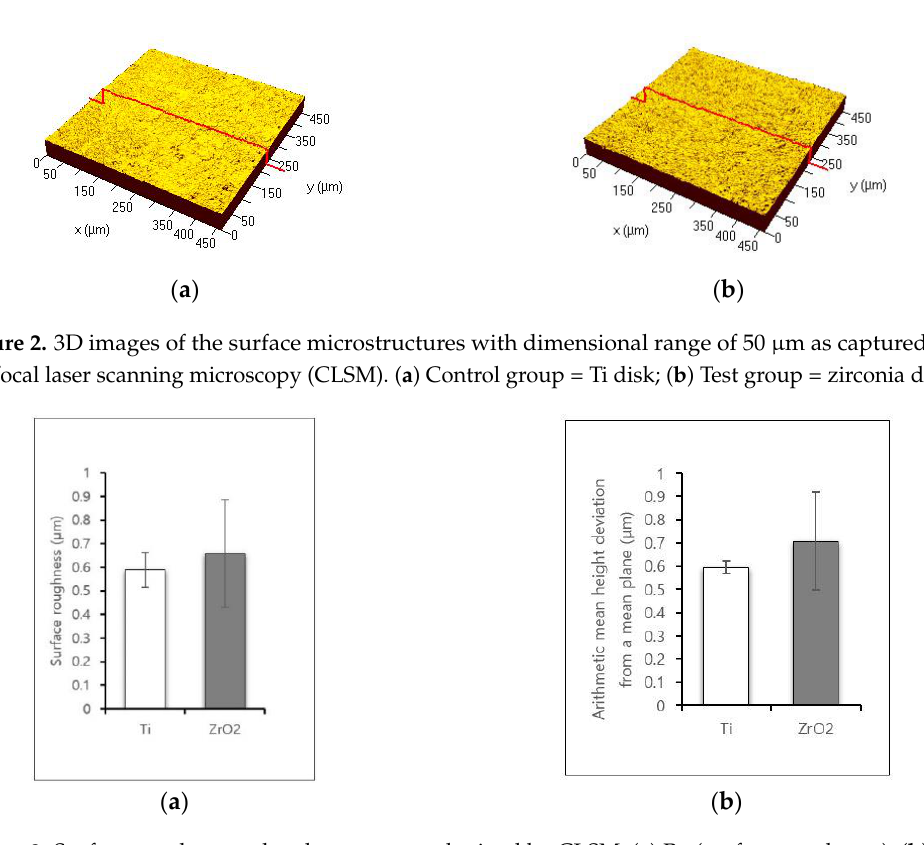
Figure 1. Scanning electron microscope (SEM) images of the surfaces of Ti disk and zirconia disk; Control group = Ti disk; each row, left to right, original magnification ( a ) 1000 × ; ( b ) 5000 × ; ( c ) 20,000 × . Test group = zirconia disk: ( d ) 1000 × ; ( e ) 5000 × ; ( f ) 20,000 × .